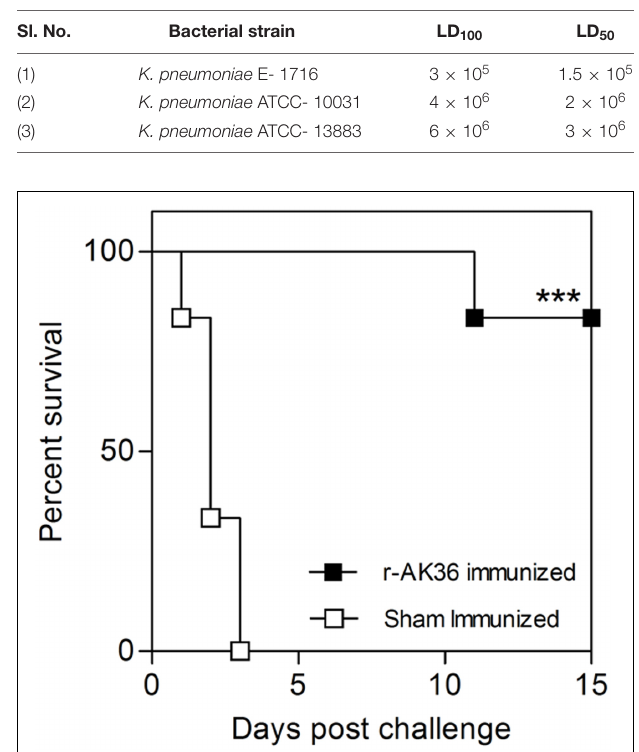
FIGURE 5 | Challenge studies in r-AK36-immunized mice. Kaplan–Meier’s survival graph for r-AK36-immunized and sham-immunized mouse challenged with LD of K. pneumoniae E-1716 strain. One animal succumbed to death (83% survival) in active immunized group, but none survived in sham-immunized group. Significance ( P )-value summary: ∗∗∗ P ≤